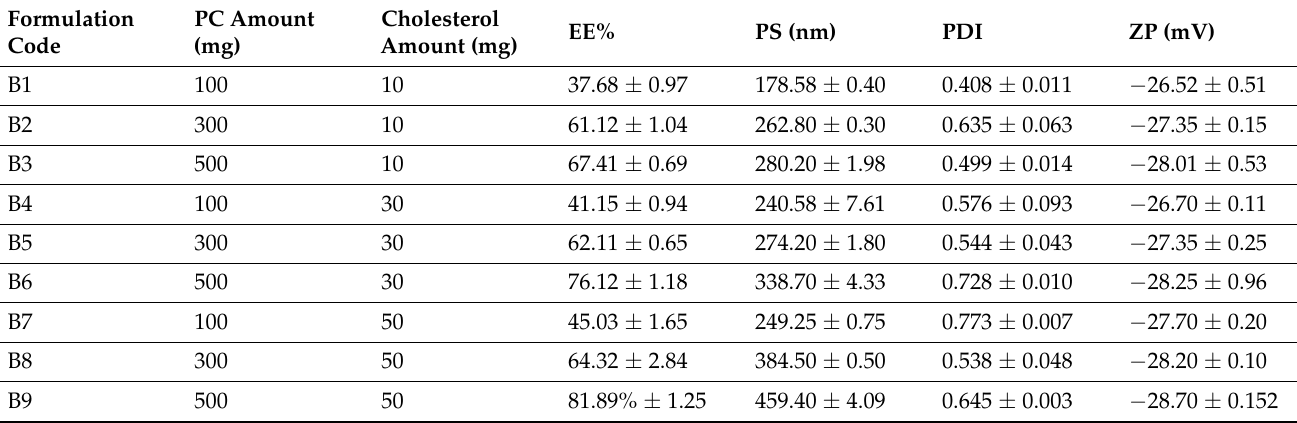
Table 1. Experimental runs, independent variables, and measured response of the 3 2 full factorial design for optimization of BEO loaded NPs.